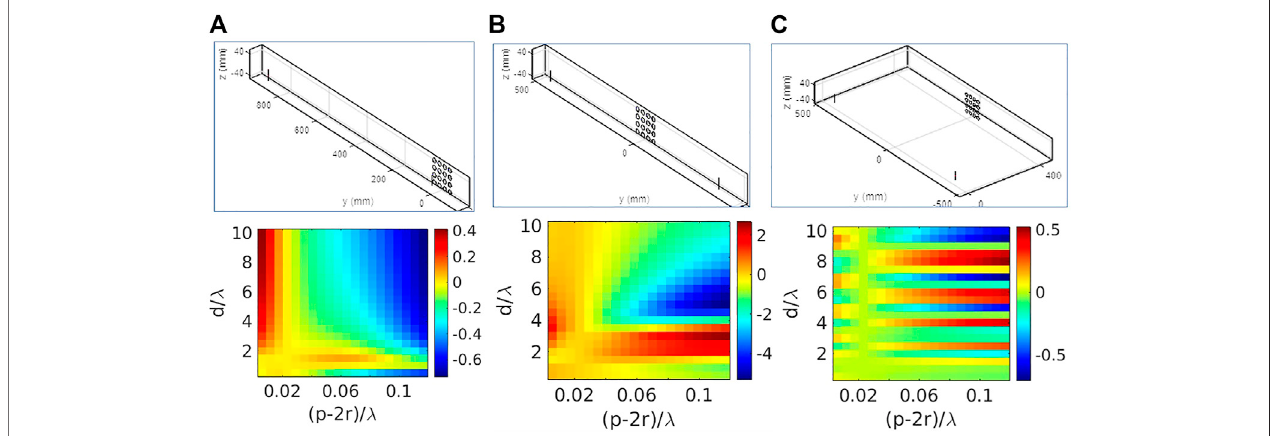
FIGURE 7 | Effect of mutual coupling between IRS unit-cells upon the distribution of Δ G : (A) s (cid:1) 0.5 λ for con fi guration in Figure 1B s (cid:1) 0.5 λ for con fi guration in Figure 5C s (cid:1) 5 λ for con fi guration in Figure 5 .